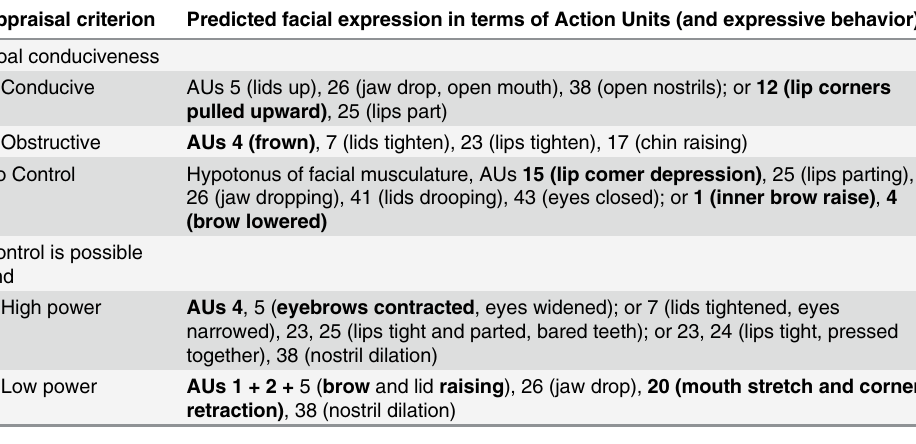
the Actions Units that are in bold